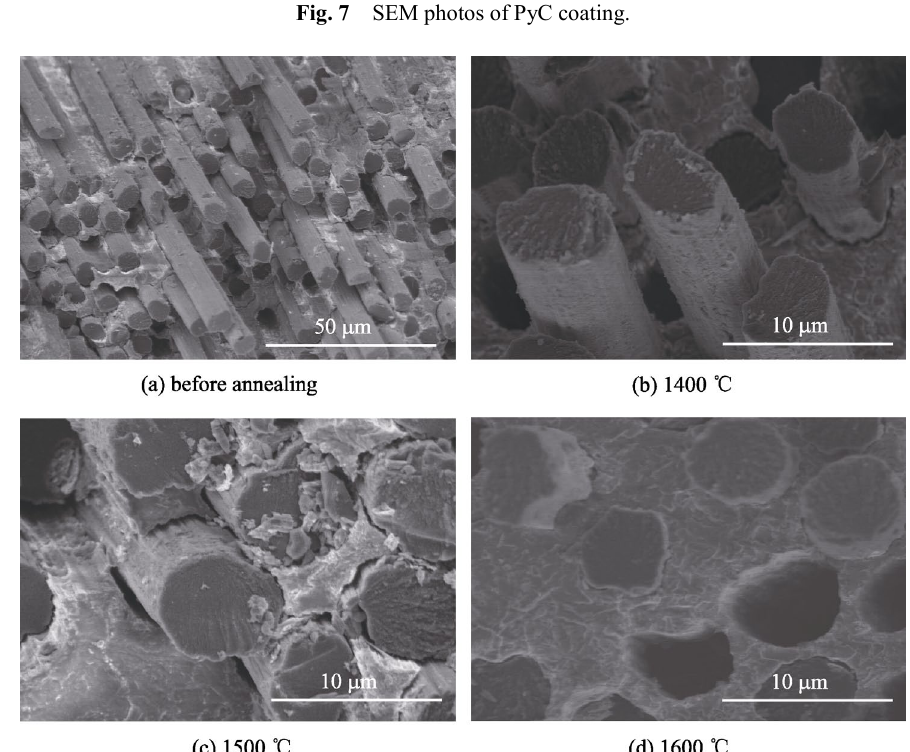
Fig. 8 Fracture surfaces of the C/PyC/mullite composites (a) before annealing and after annealing at (b) 1400, (c) 1500, and (d) 1600 ℃ .